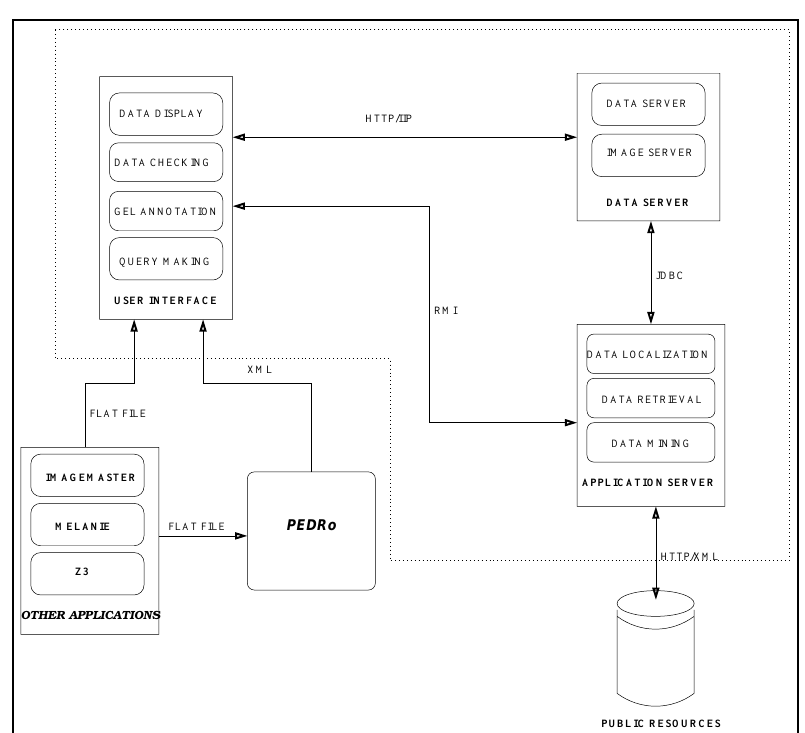
Figure 2: The architecture of the 2-DE centered